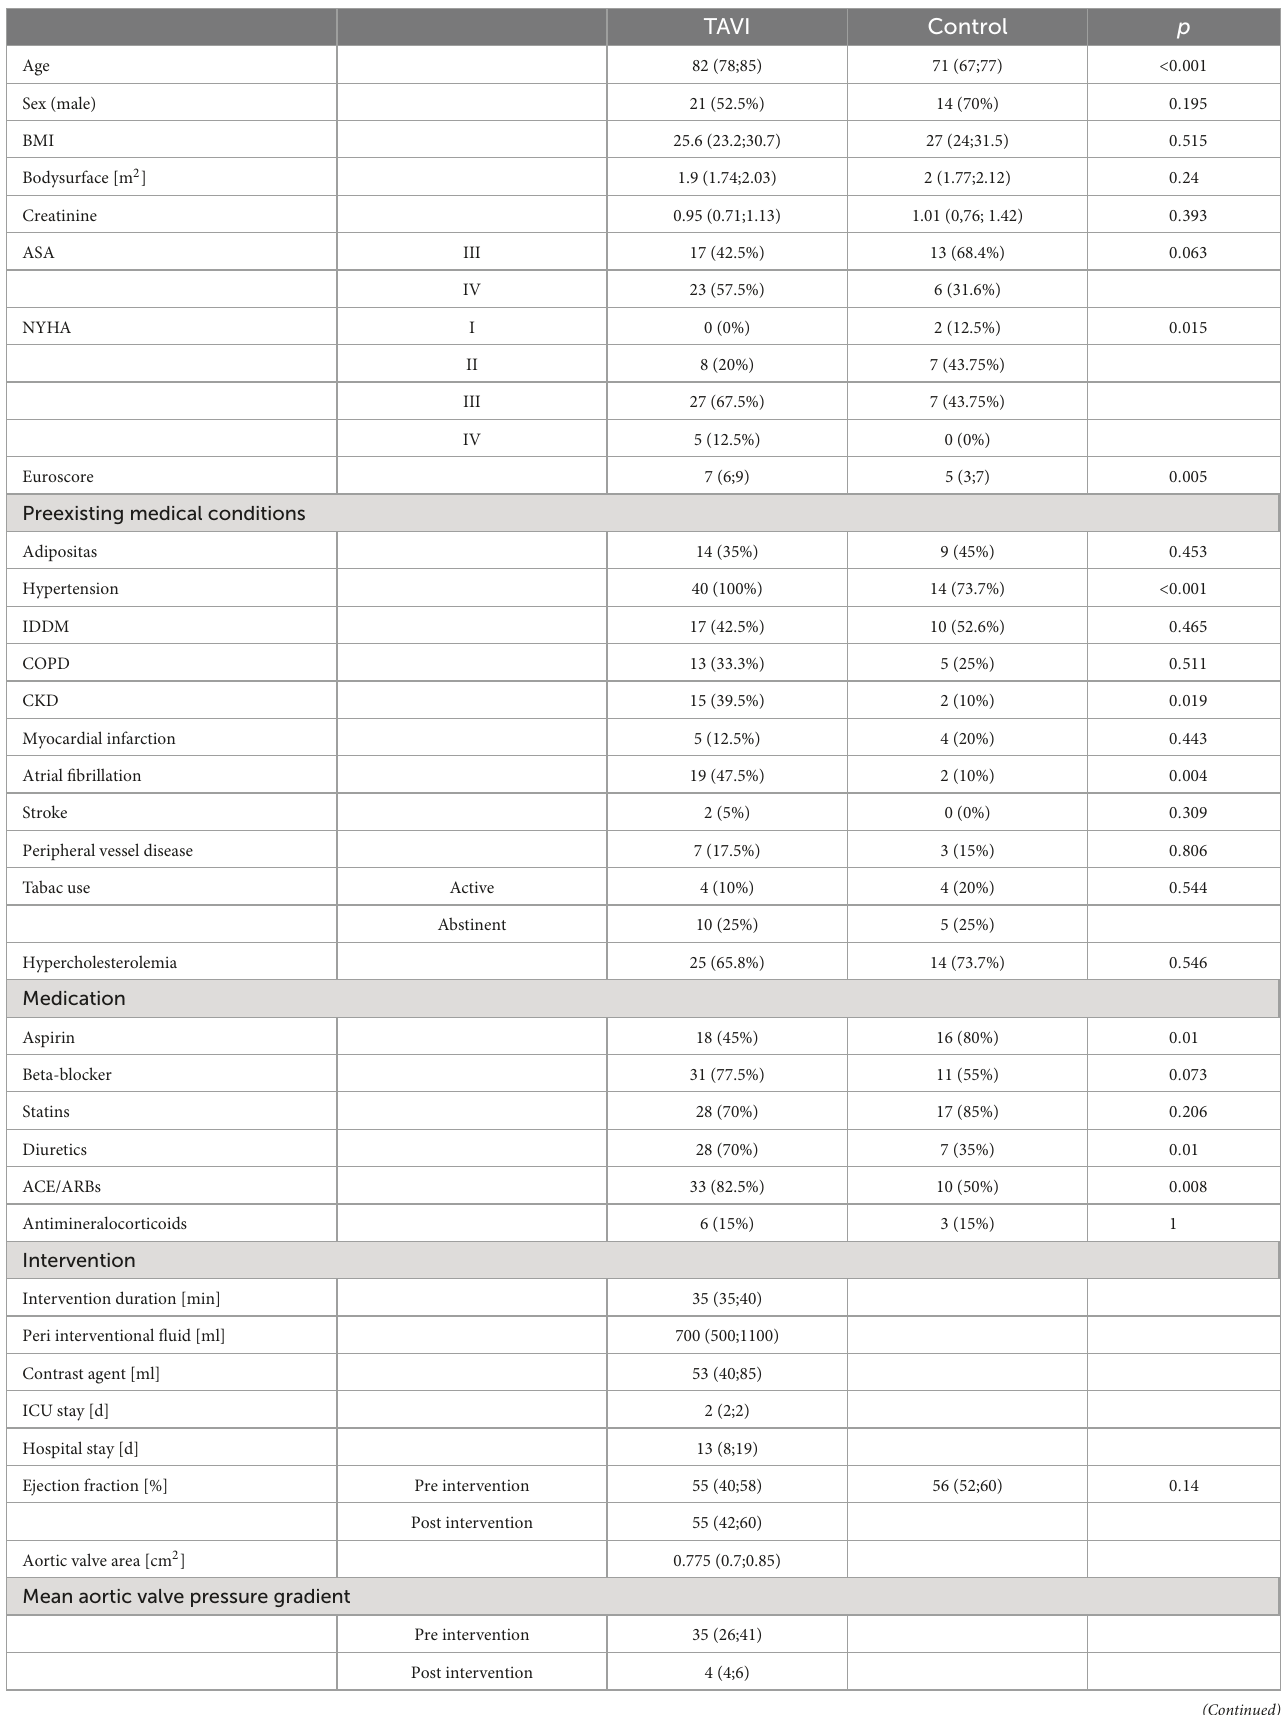
TABLE 1 Patient Characteristics; categorical values are given in absolute and relative frequencies, a Chi-Squared-Test was used for analysis.